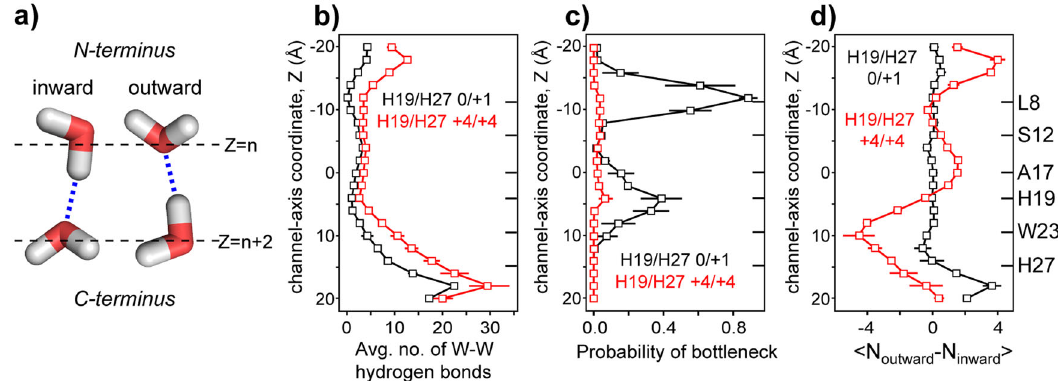
Fig. 7 Water – water hydrogen bonding in the closed and open BM2 channels. a De fi nition of the inward and outward water hydrogen bonds. b Average number of water – water hydrogen bonds along the channel axis. The open channel has more hydrogen bonds than the closed channel. c Probability of hydrogen-bond bottlenecks along the channel axis. The closed BM2 channel has high probabilities of bottlenecks at L8 and H19, while the open channel has low bottleneck probabilities throughout the channel. d Direction of water – water hydrogen bonds. The closed channel shows little preference for the hydrogen-bond polarity, while the open channel exhibits a bipolar hydrogen-bond orientation, reversed at H19. Error bars for simulations are the standard error of the mean for four independent